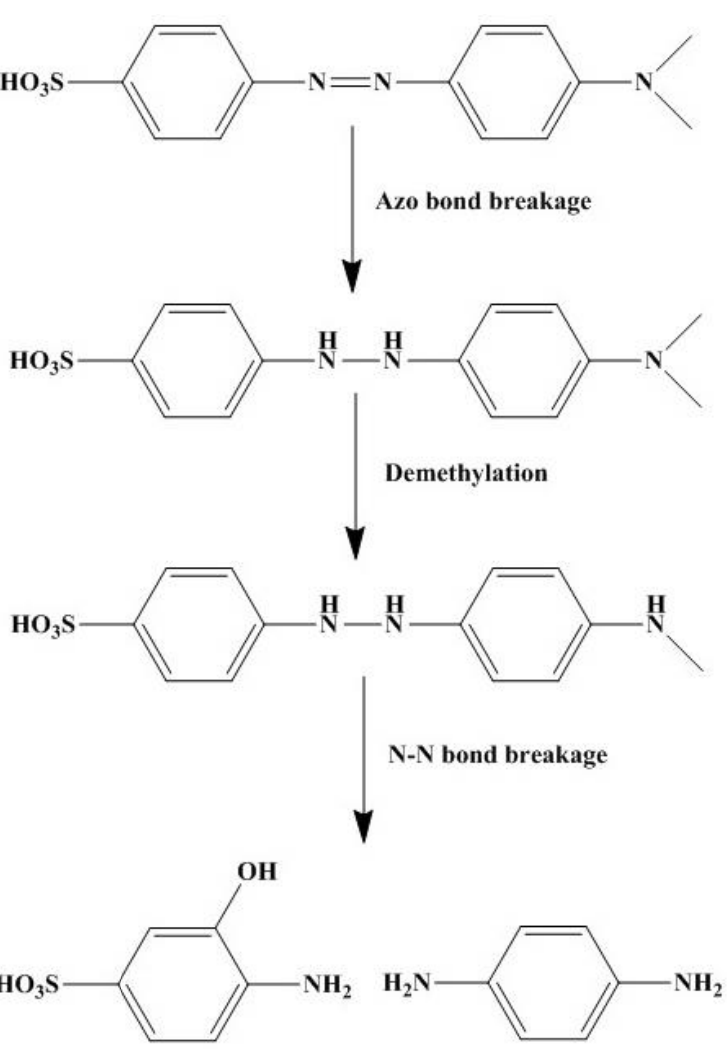
Figure 9. Degradation pathway of MO.